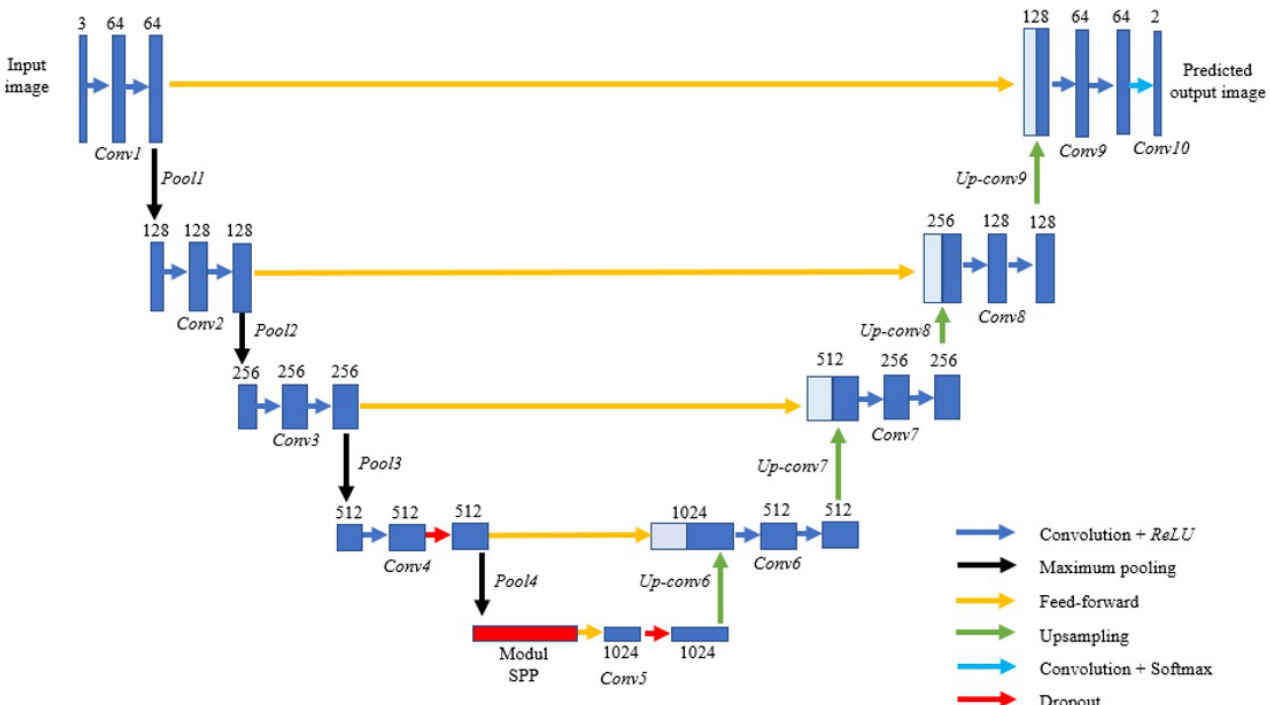
Figure 2. U-Net with a multi-scale module embedded at the bottleneck